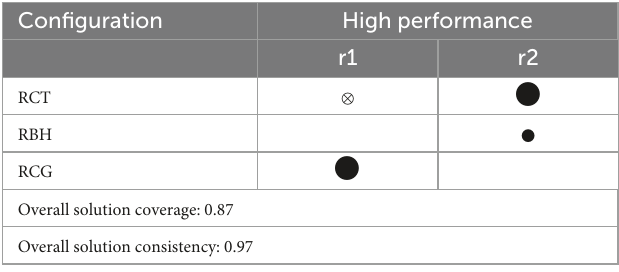
Largecirclesindicatecoreconditionsandsmallcirclesperipheralconditions.Blackcircles(“ indicate the “presence” of a condition, crossed-out circles (“ ⊗ ”) indicate its “negation,” and blankspacesinthesolutionsindicate“don’tcare.”